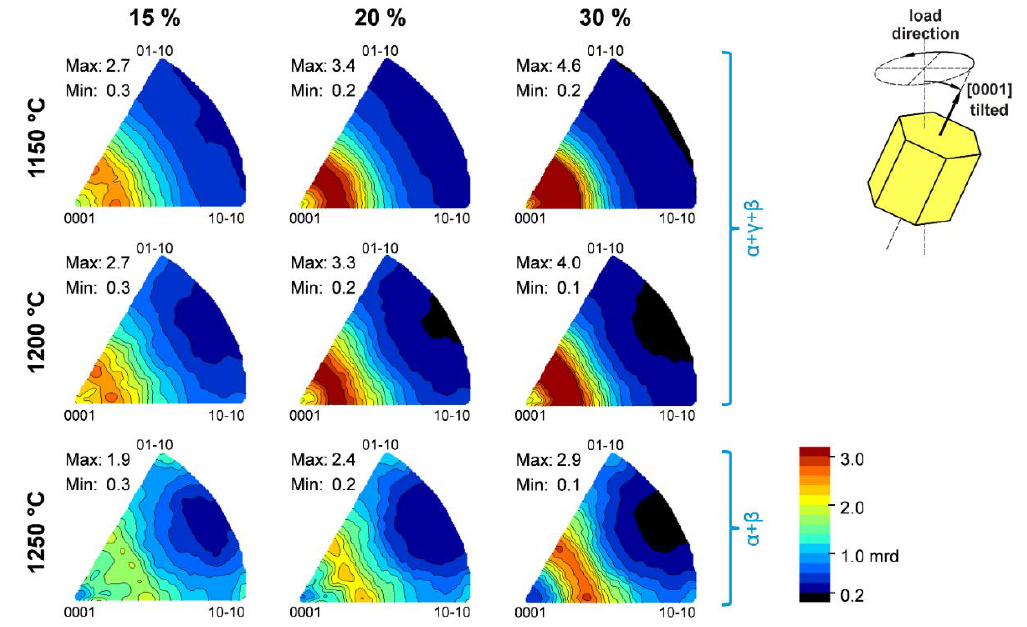
Figure 6. Evolution of the α phase deformation texture during hot compression at different forming temperatures represented as inverse pole figures in load direction after 15%, 20%, and 30% deformation. The sketch on the right illustrates the tilted basal fiber texture which is typically